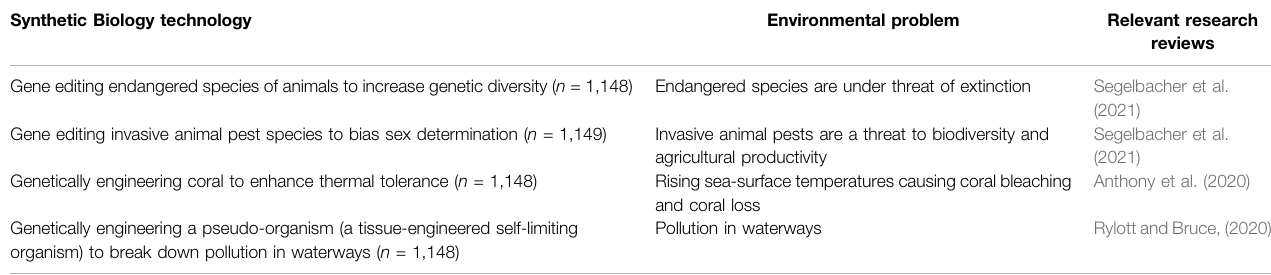
TABLE 1 | The synthetic biology technologies